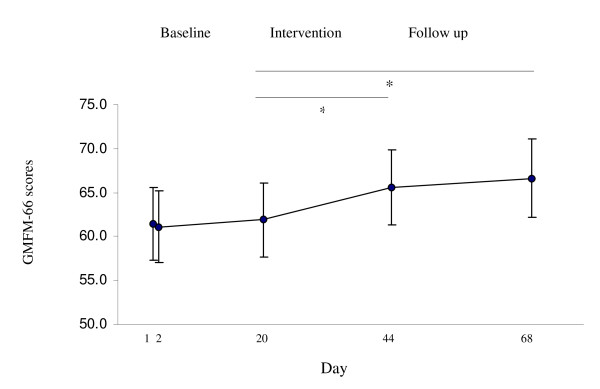
Mean GMFM-66 scores and SEM from baseline and follow up measurements (n = 22) * p < 0.01.